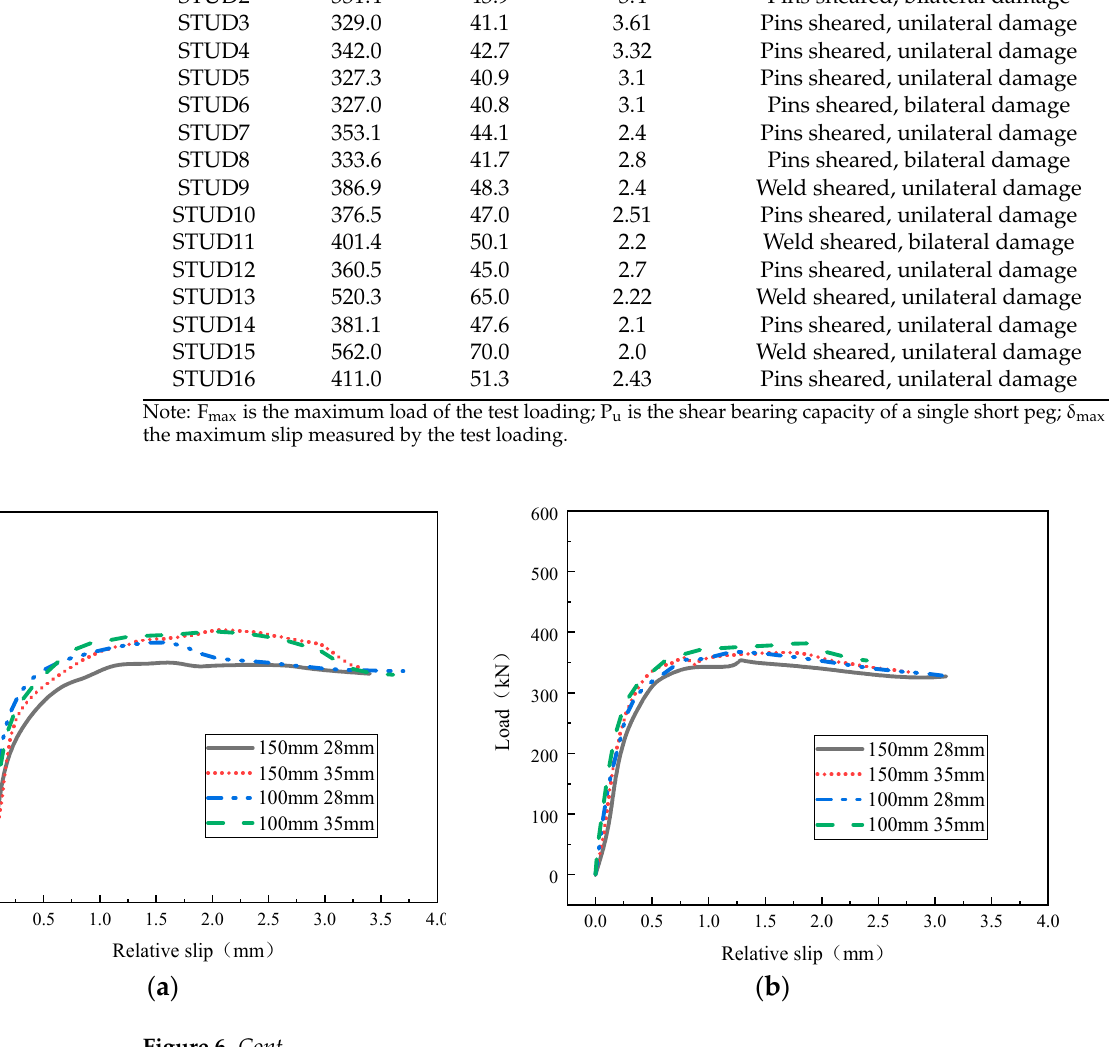
Table 5. Main results of the test.